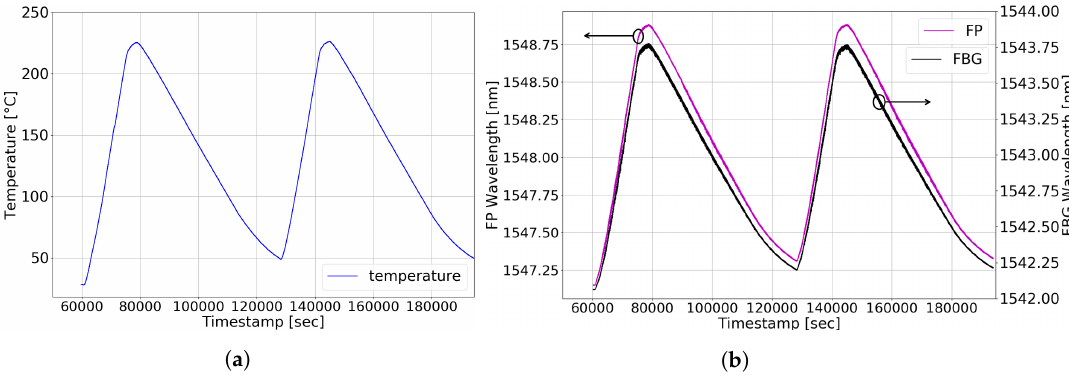
Figure 13. Temperature testing: ( a ) thermal cycles; and ( b ) absolute wavelength response.